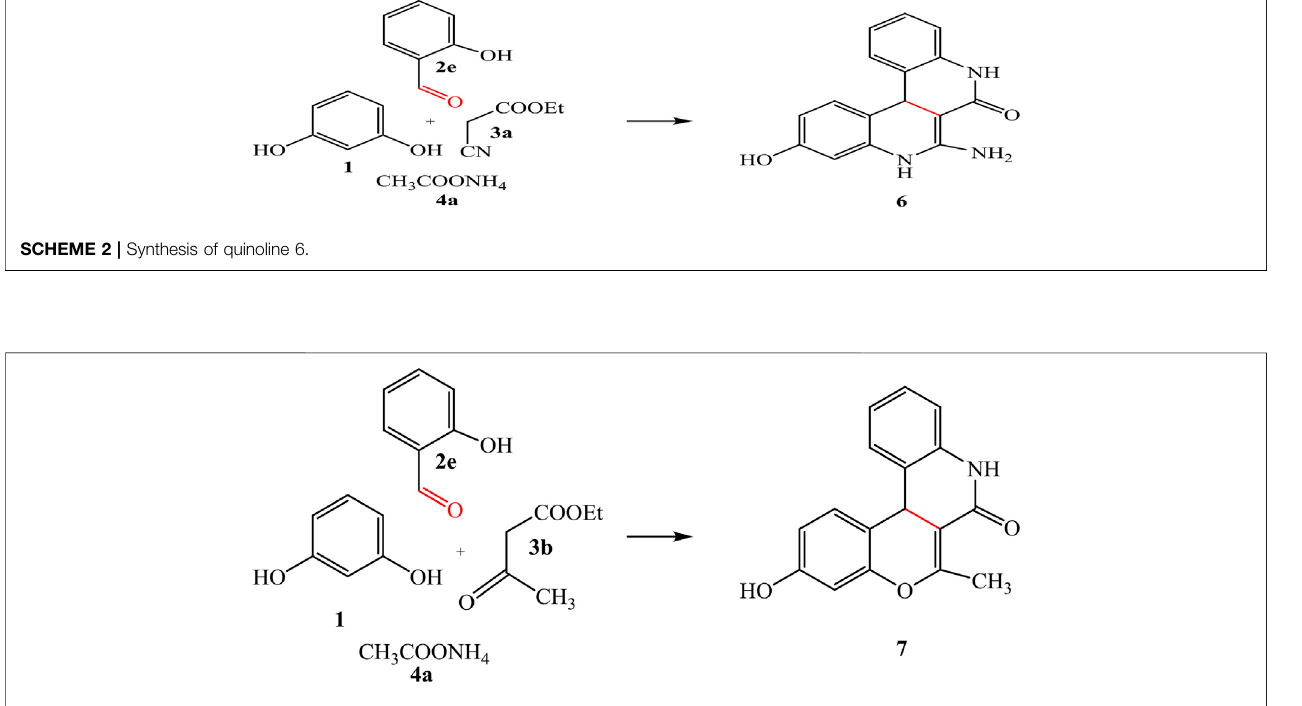
Frontiers in Chemistry |